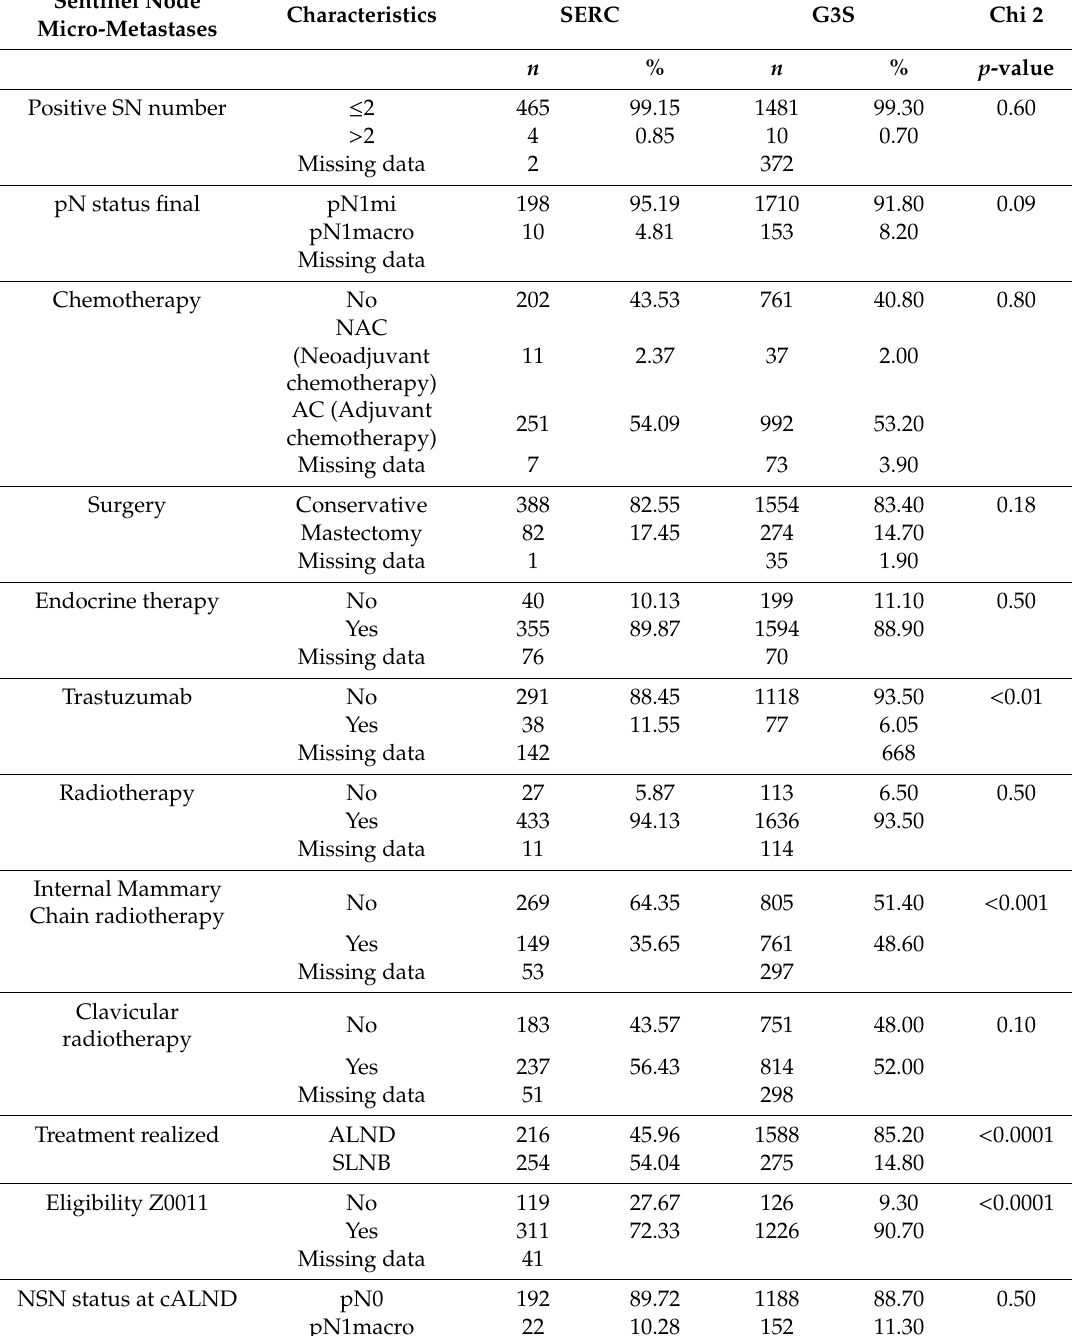
NSN rates at cALND were 10.28% and 11.3% in the SERC trial and French cohort, respectively ( p = 0.5). The SERC trial recruited patients between 2012 and 2018 while the French cohort population included patients between 2009 and